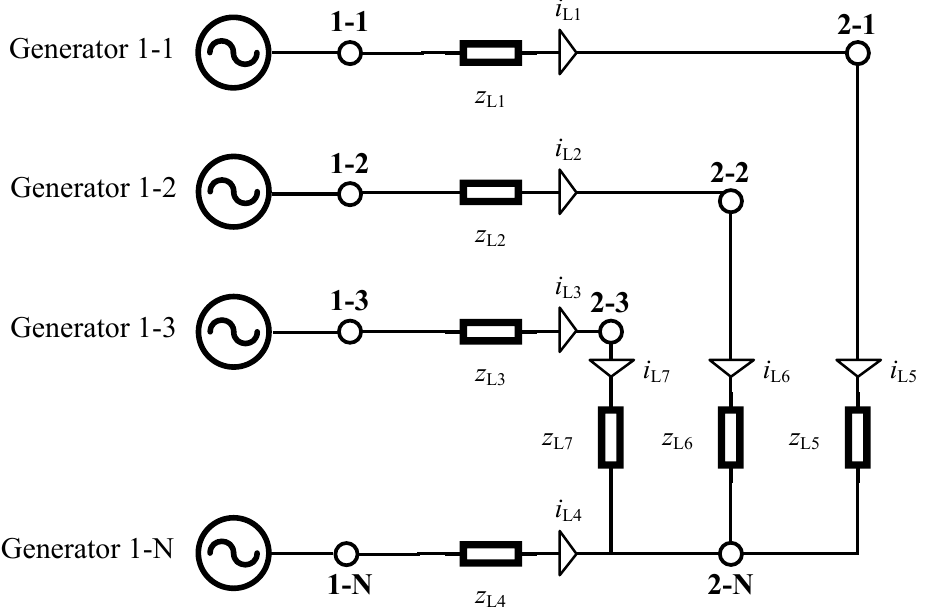
Figure 3. Model of the grid for three-phase OPF